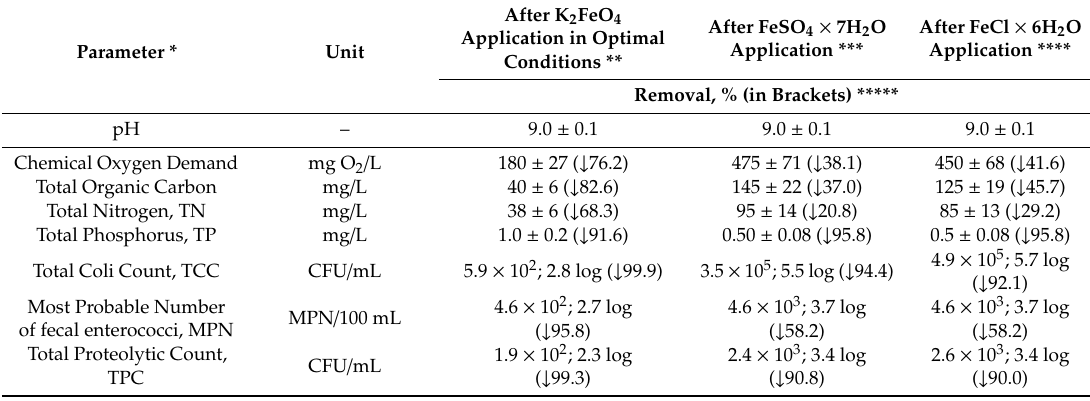
Table 6. Selected physicochemical parameters of treated landfill leachate after K 2 FeO 4 , FeSO 4 × 7H 2 O and FeCl 3 × 6H 2 O